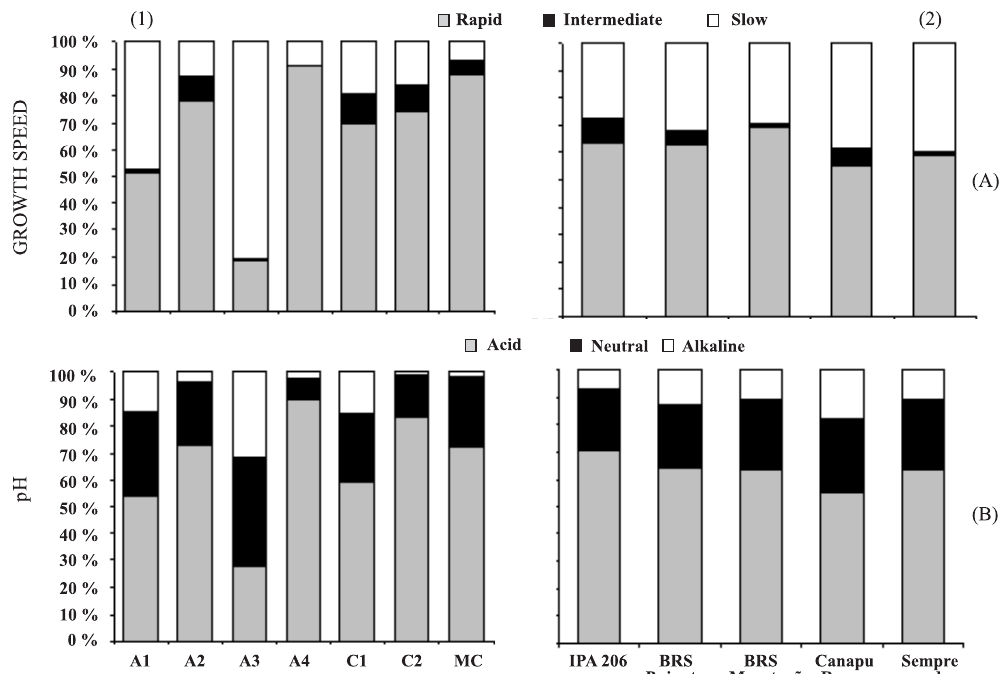
Figure 1. Rhizobium frequency in relation to the growth speed (A) and to the pH reaction (B) according to the origin (1) and cowpea cultivar associated